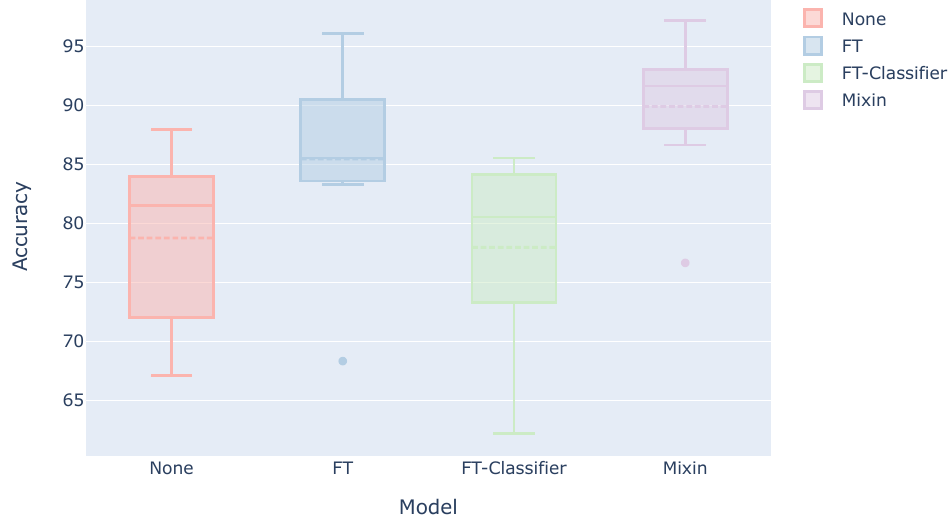
Figure 6. Estimation accuracy when using the user data for training.